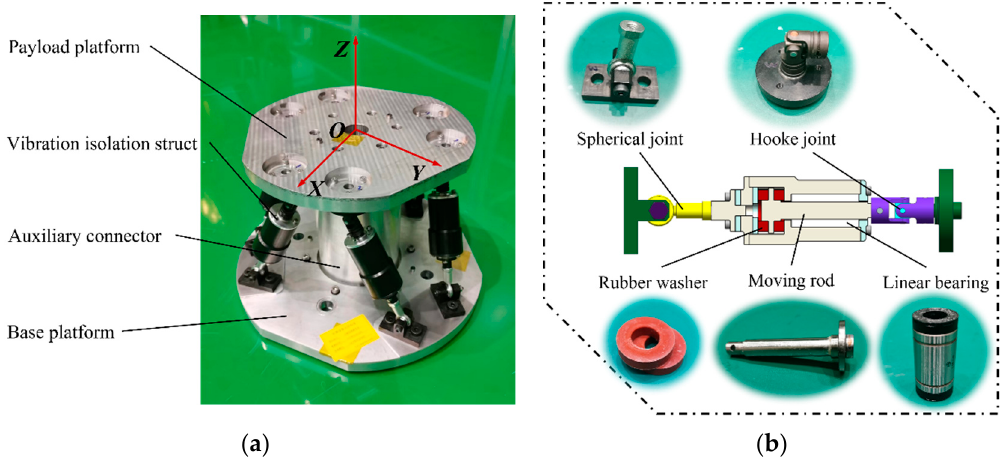
Figure 8. Diagram of SVIP prototype: ( a ) overview of SVIP; ( b ) structure of the strut.